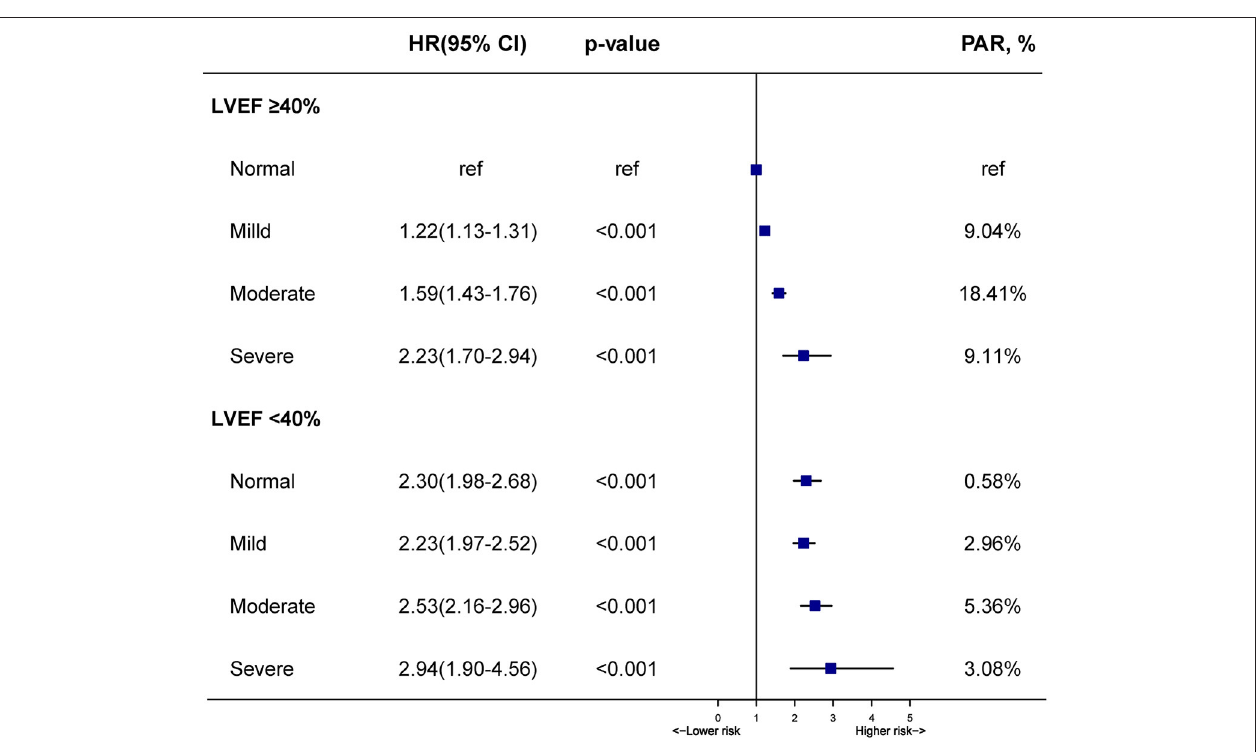
with CAG are as follows. For patients with poor cardiac function, LV dysfunction caused the release of natriuretic peptides (16), which stimulated lipolysis of adipose tissue (17), and indirectly stimulated the secretion of adiponectin to promote glucose and fatty acid utilization (18), resulting in weight loss and